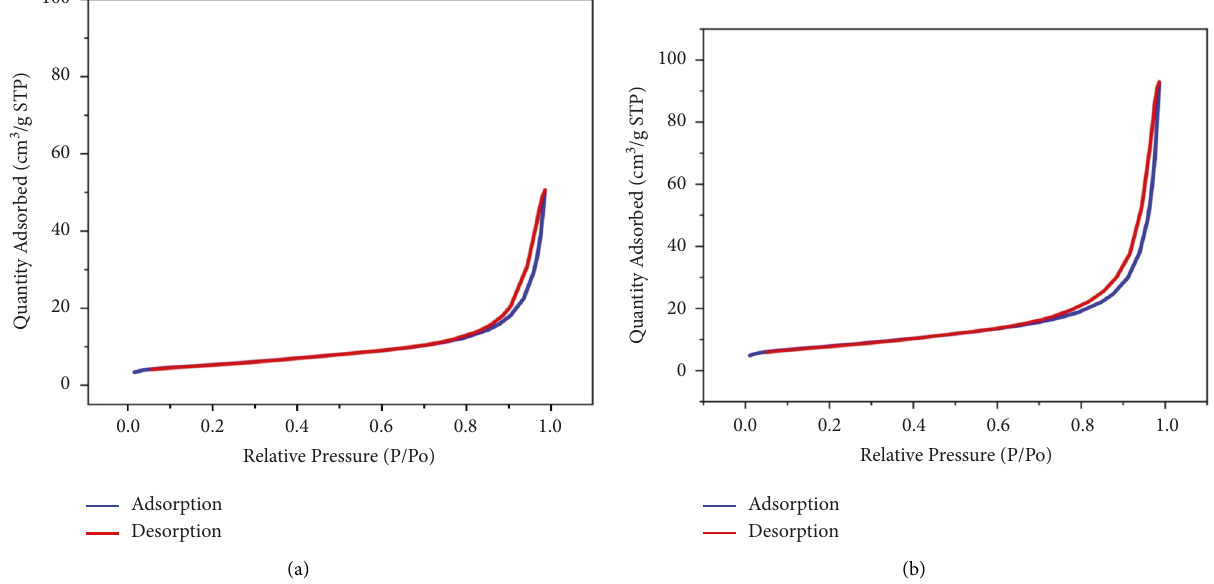
Figure 1: Adsorption-desorption isotherms of (a) zinc oxide nanoparticles (ZnONPs) and (b) plant-fabricated zinc oxide nanoparticles